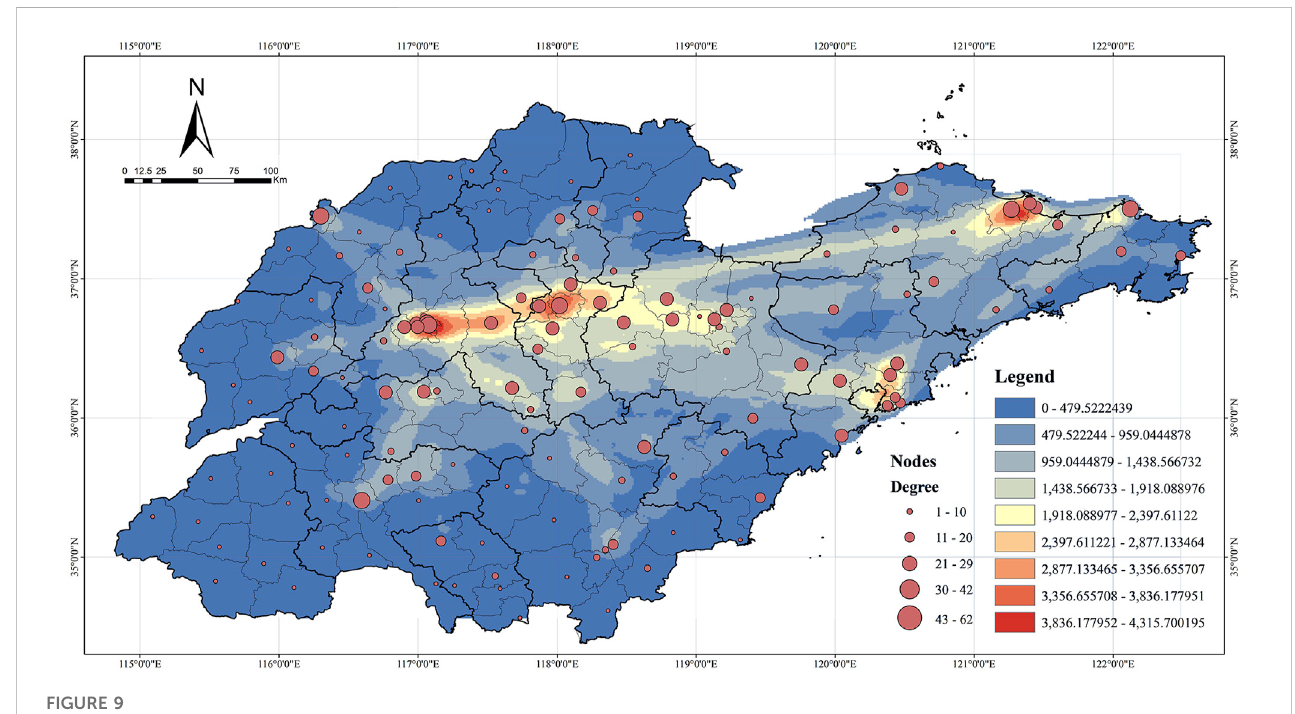
FIGURE 9 Line Density Analysis of City Supply Network Edges of